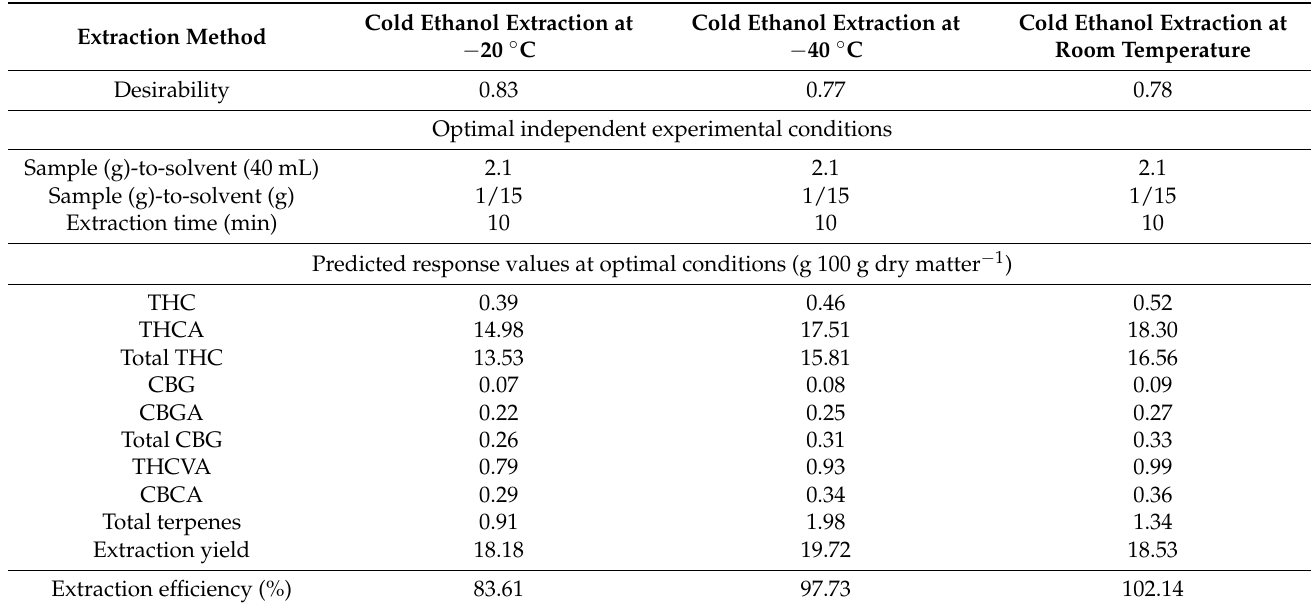
Table 3. Optimal experimental conditions for cold ethanol extraction of cannabis at − 20 ◦ C, − 40 ◦ C, and room temperature and the predicted response